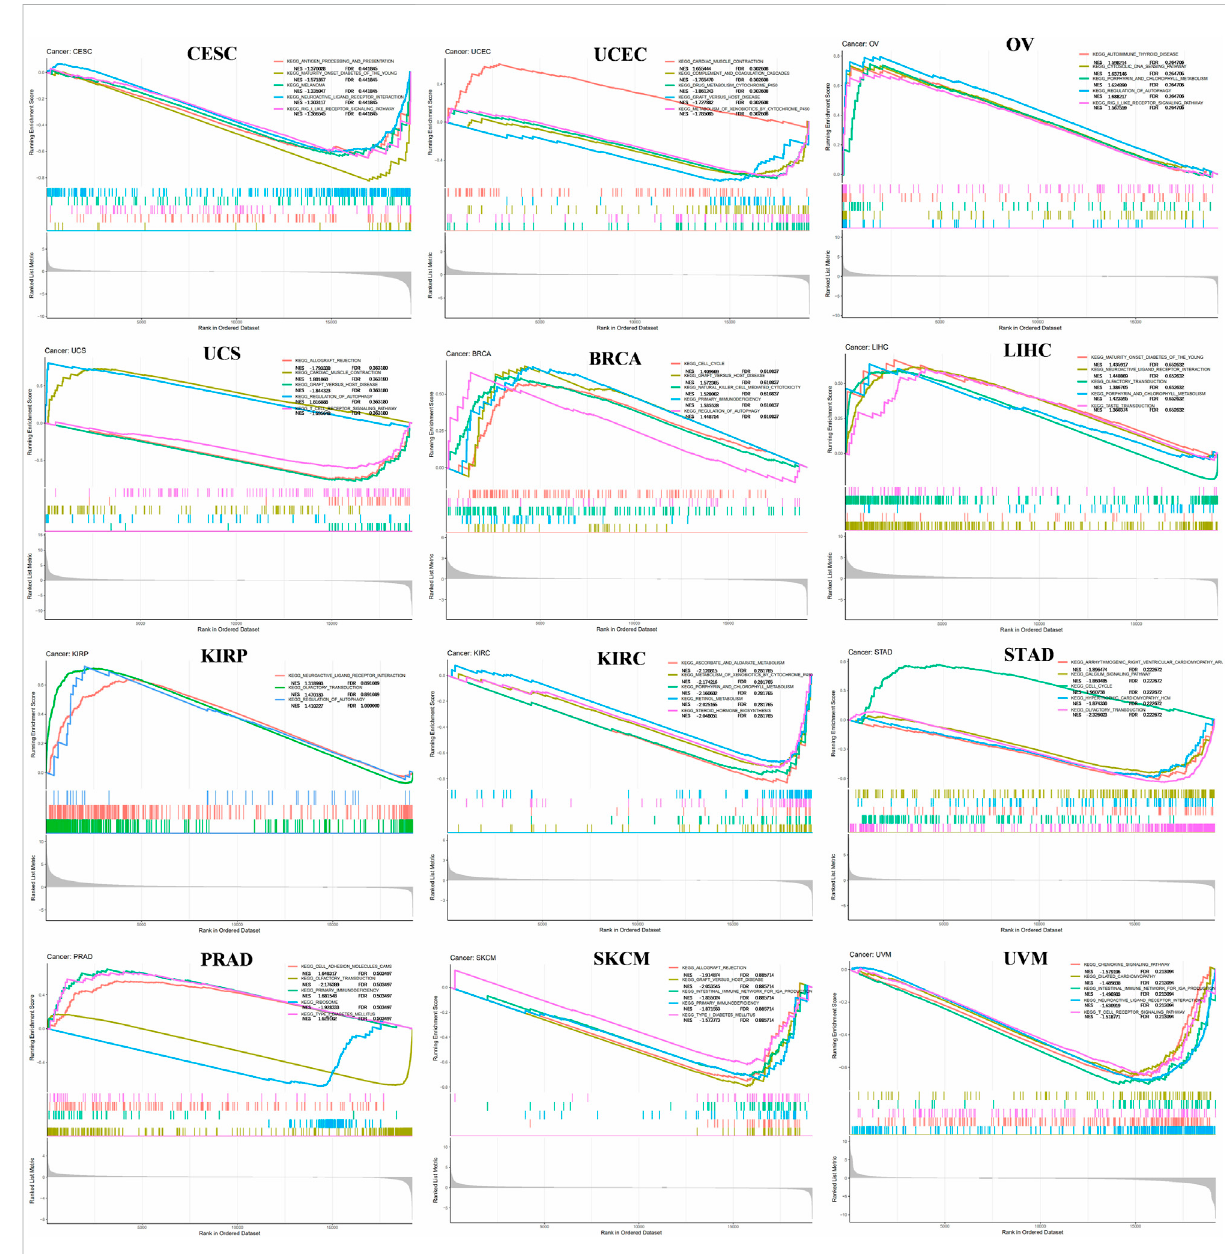
FIGURE 3 Gene set enrichment analysis (GSEA) of FANCE expression in cancers. The top fi ve most relevant signaling pathways in the Kyoto Encyclopedia of Genes and Genomes (KEGG) dataset were displayed. Normalized Enrichment Score (NES) value and FDR value (qvalue) were displayed. Peaks on the upward curve indicate positive regulation and peaks on the downward curve indicate negative